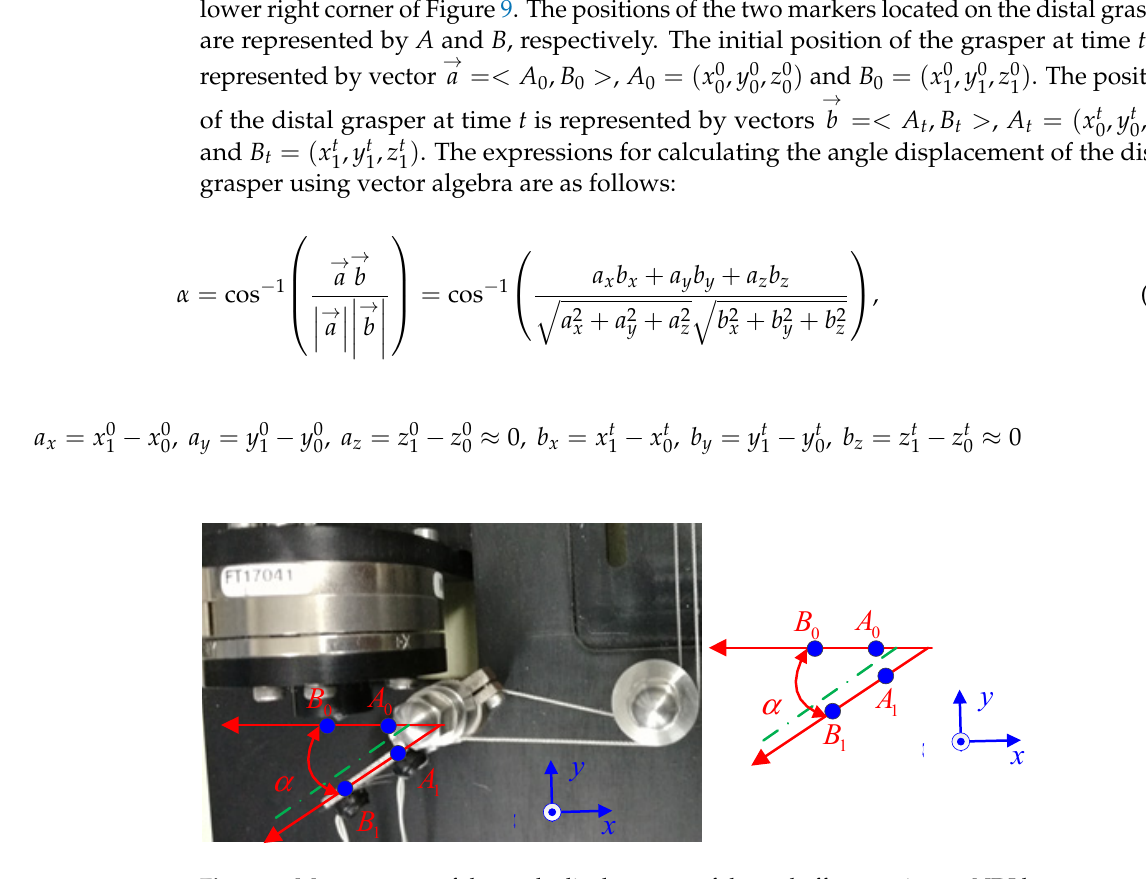
Figure 9. Measurement of the angle displacement of the end effector using an NDI locator.